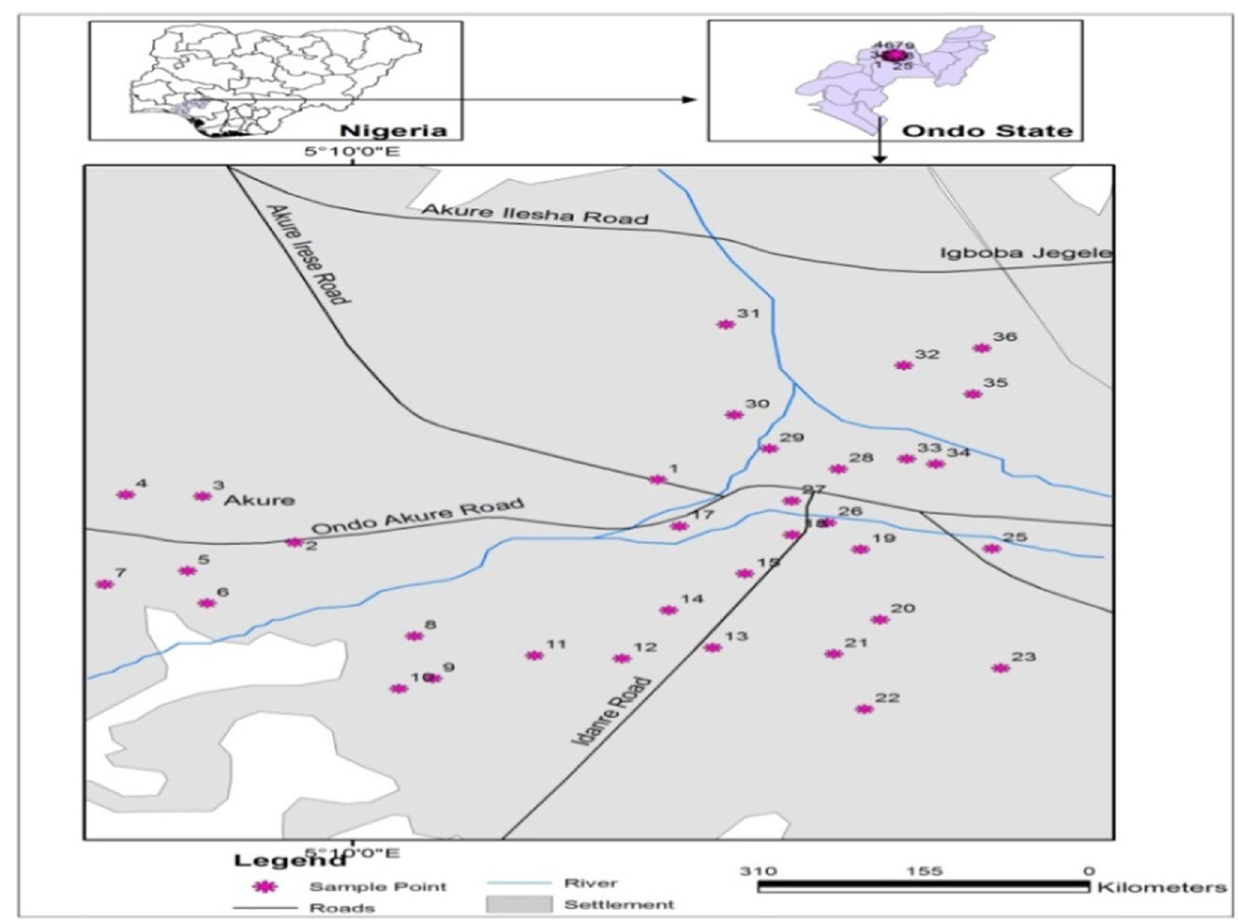
Fig. 1 Sampling map of the study